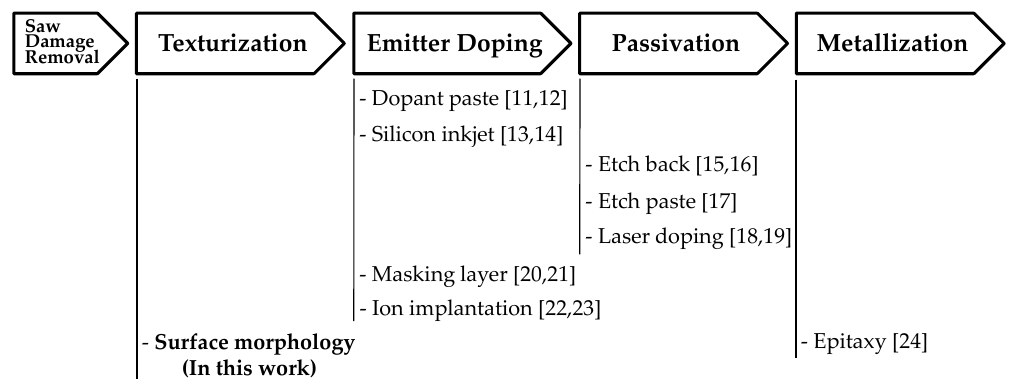
Figure 1. Comparison between the processes for selective emitter (SE) technologies used in our study and in previous studies [11–24].